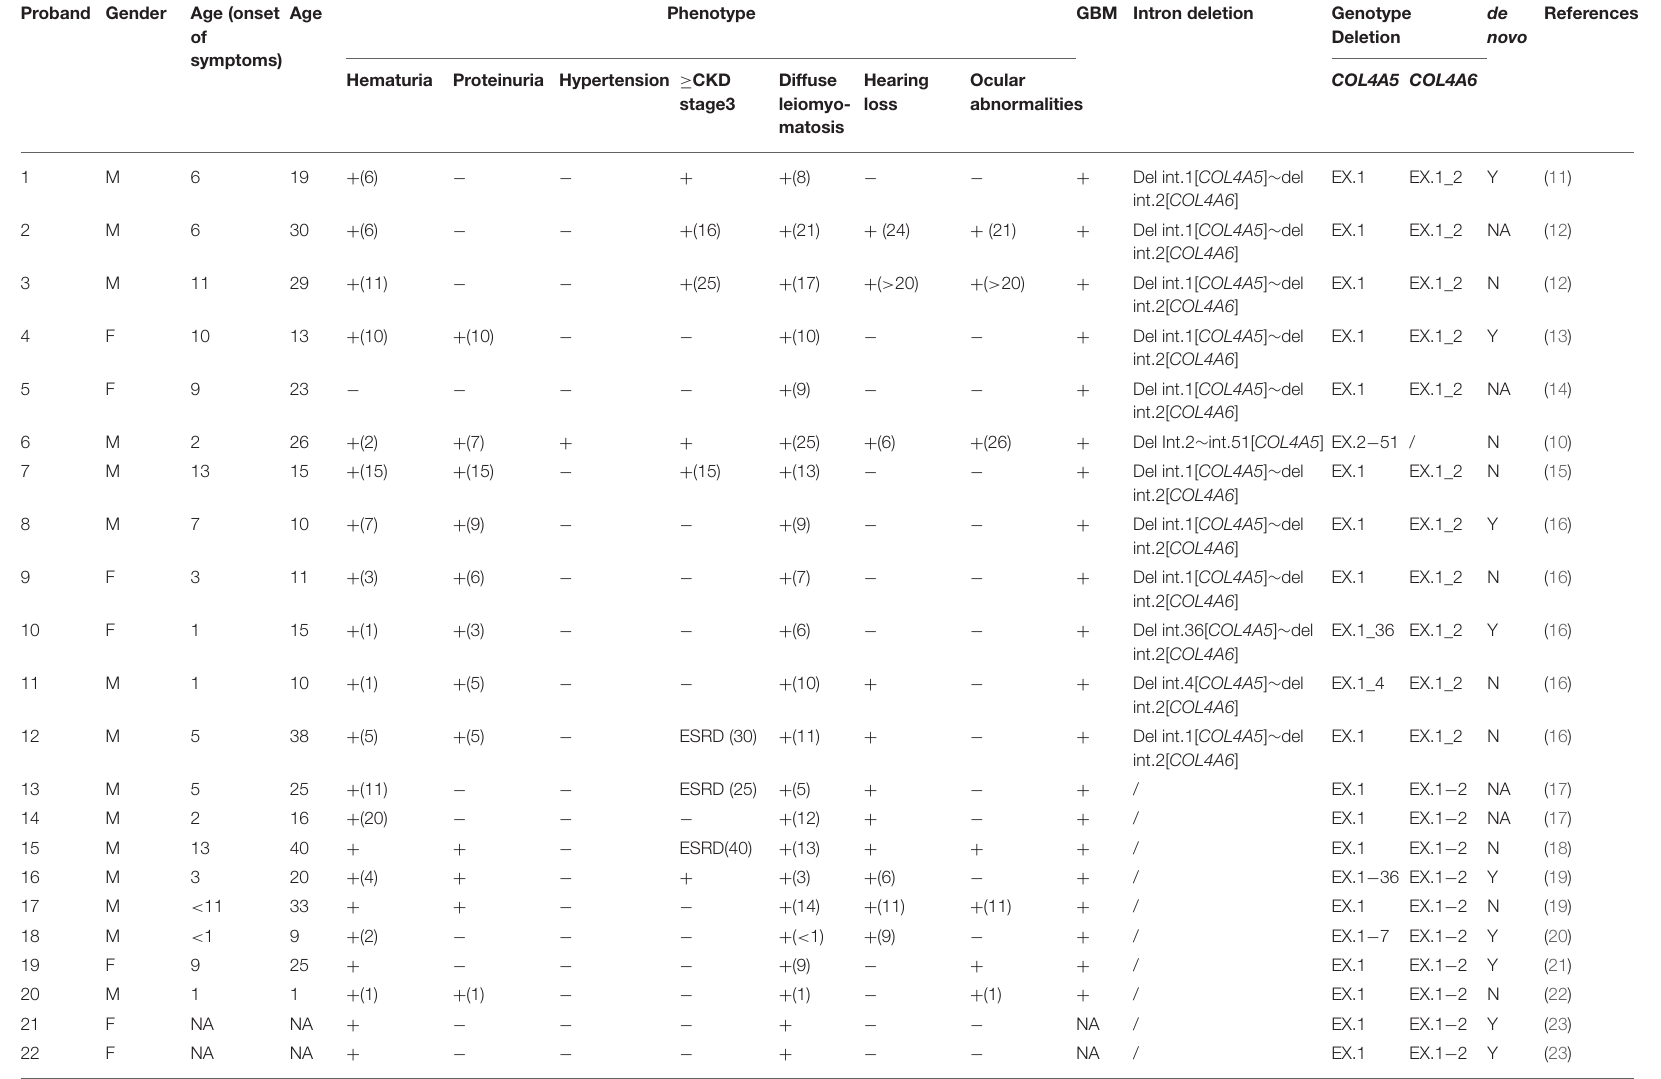
TABLE 1 | Clinical and genetic characterisation of patients with Alport syndrome − diffuse leiomyomatosis. Proband Gender Age (onset